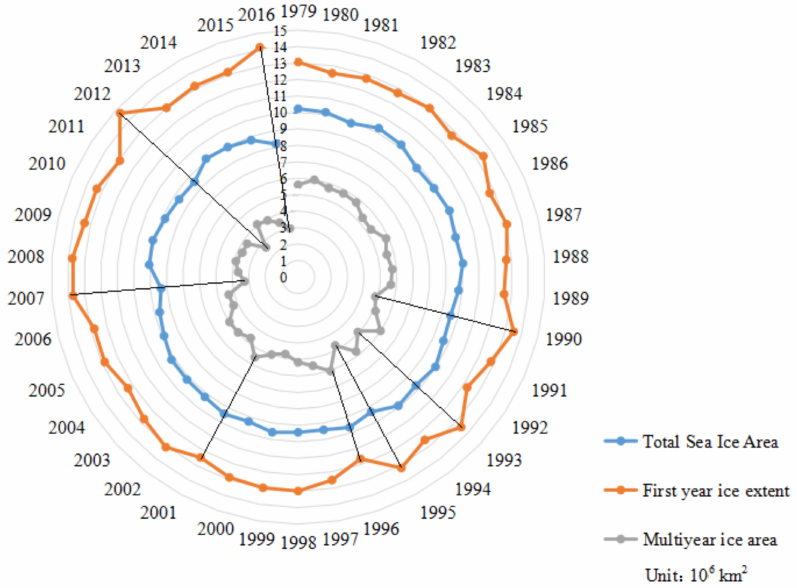
Figure 7. Comparisons of total sea ice area, first-year ice extent and multi-year ice